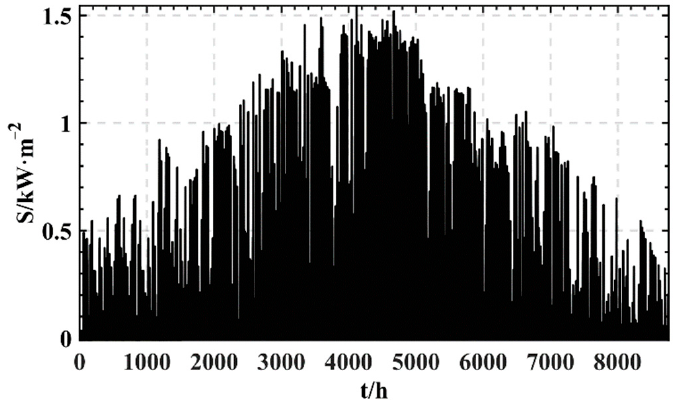
Figure 5. Annual distribution of light radiation intensity.